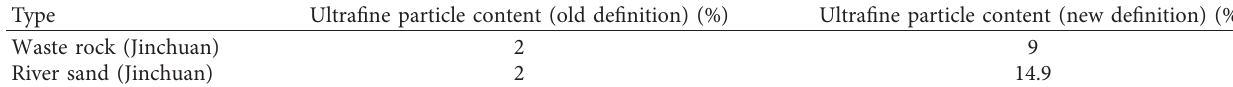
Table 1: Comparison of new and old definitions of ultrafine particles.